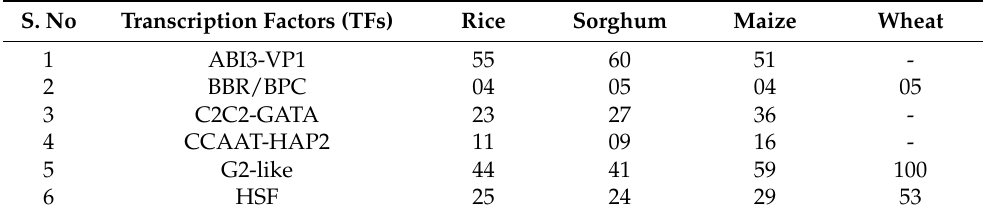
Table 2. C3 and C4 crop species transcription factor families and their number of family